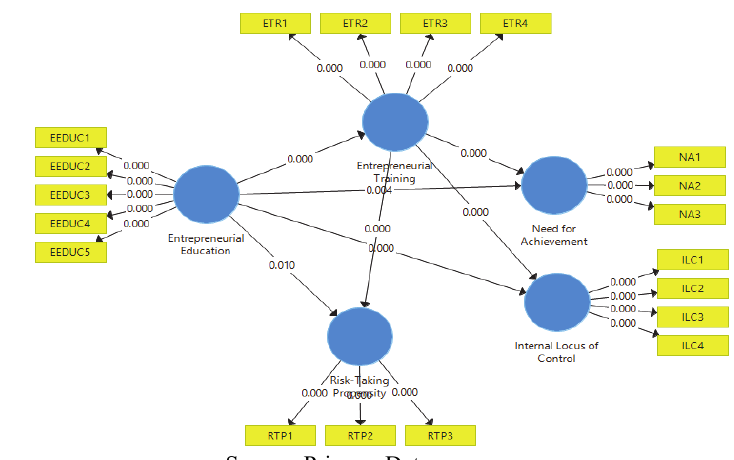
Source: Primary Data Fig. 3. Path Analysis of the Model (After Bootstrapping)